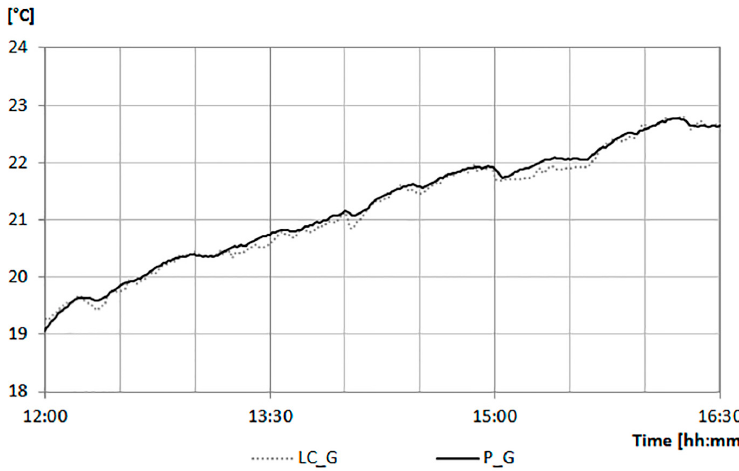
Figure 8. Radiant temperature monitored data: comparison between the low cost globe thermometer (LC_G) and professional globe thermometer (P_G).